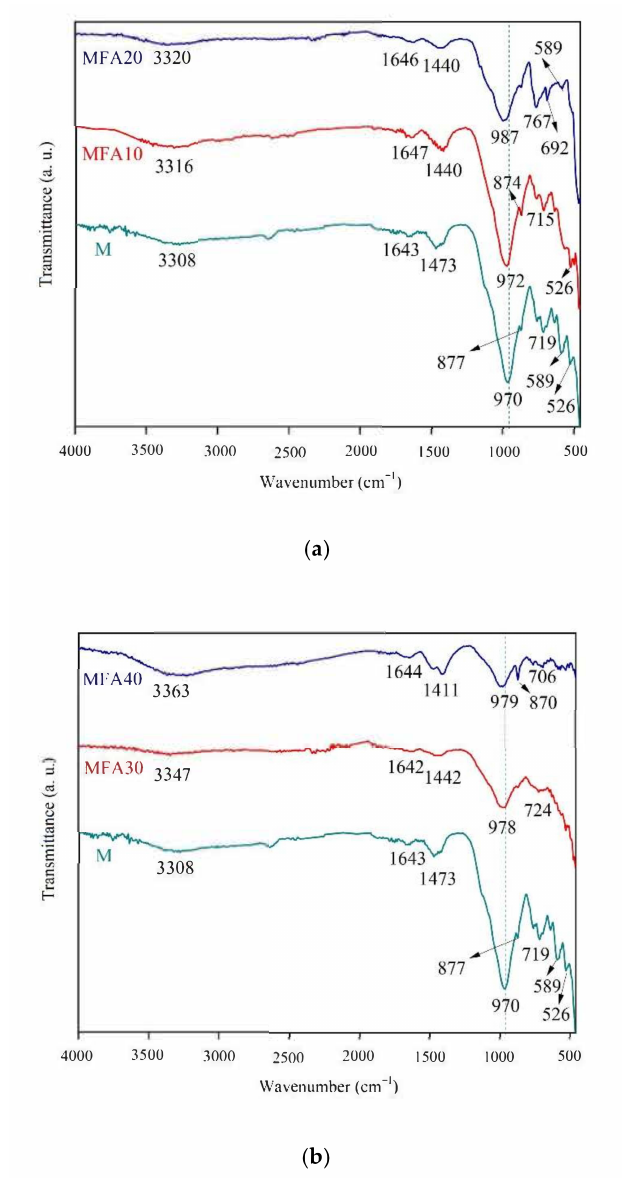
Figure 15. FTIR spectra of the MFA-GPC specimens: ( a ) MFA10 and MFA20 and ( b ) MFA30 and